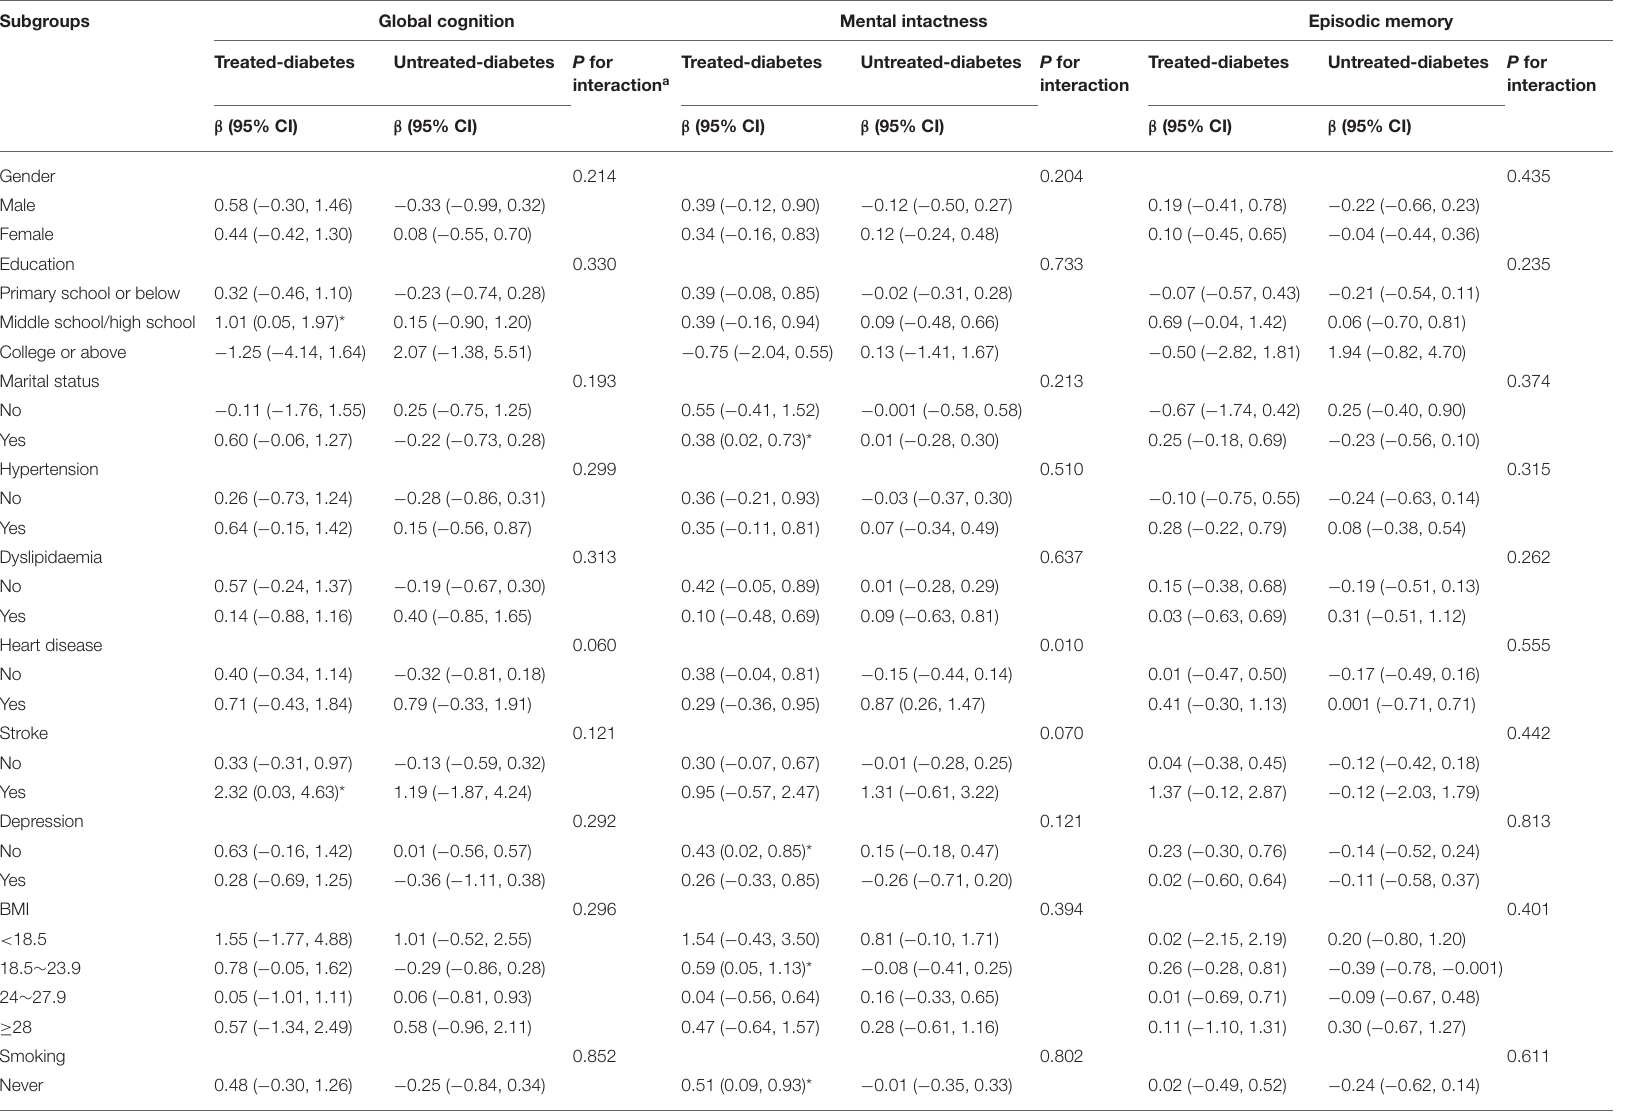
TABLE 4 | Relationships between diabetes status (diabetes-free as the reference group) and cognitive function in the subgroups ( ≥ 60